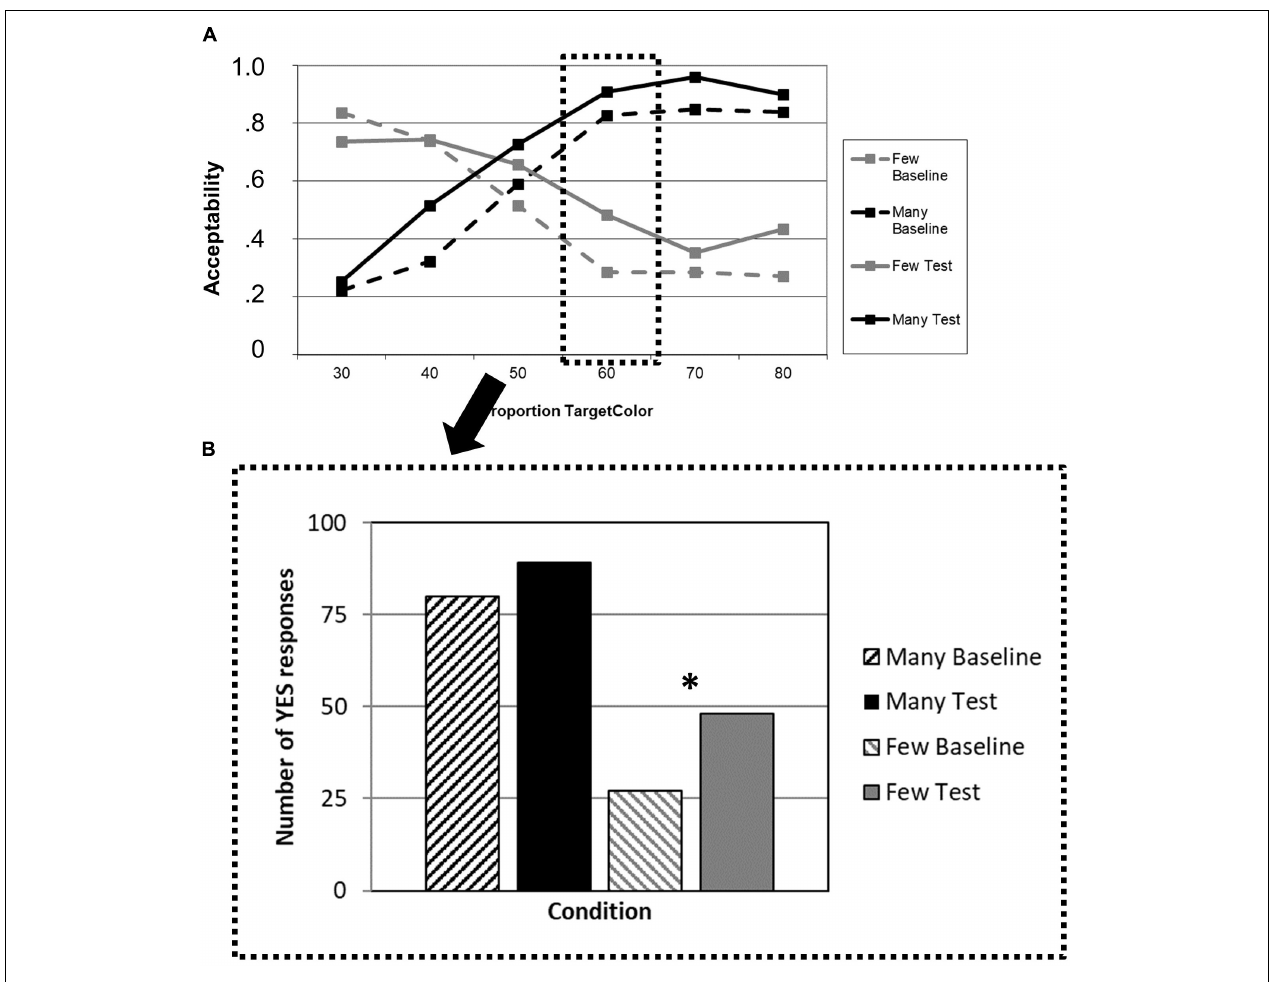
FIGURE 3 | (A) Average acceptability ratings for a given proportion of circles of the mentioned color, plotted separately for the quantifiers “ many ” (black lines) and “ few ” (gray lines) in the baseline blocks (dashed lines) and the test blocks after adaptation (solid lines). (B) Number of “yes” responses for the critical proportion (60%) of circles of the mentioned color, plotted separately for “ many ” (black bars) and “ few ” (gray bars) in the baseline blocks (dashed bars) and the test blocks after adaptation (solid bars). ∗ p < 0.05.